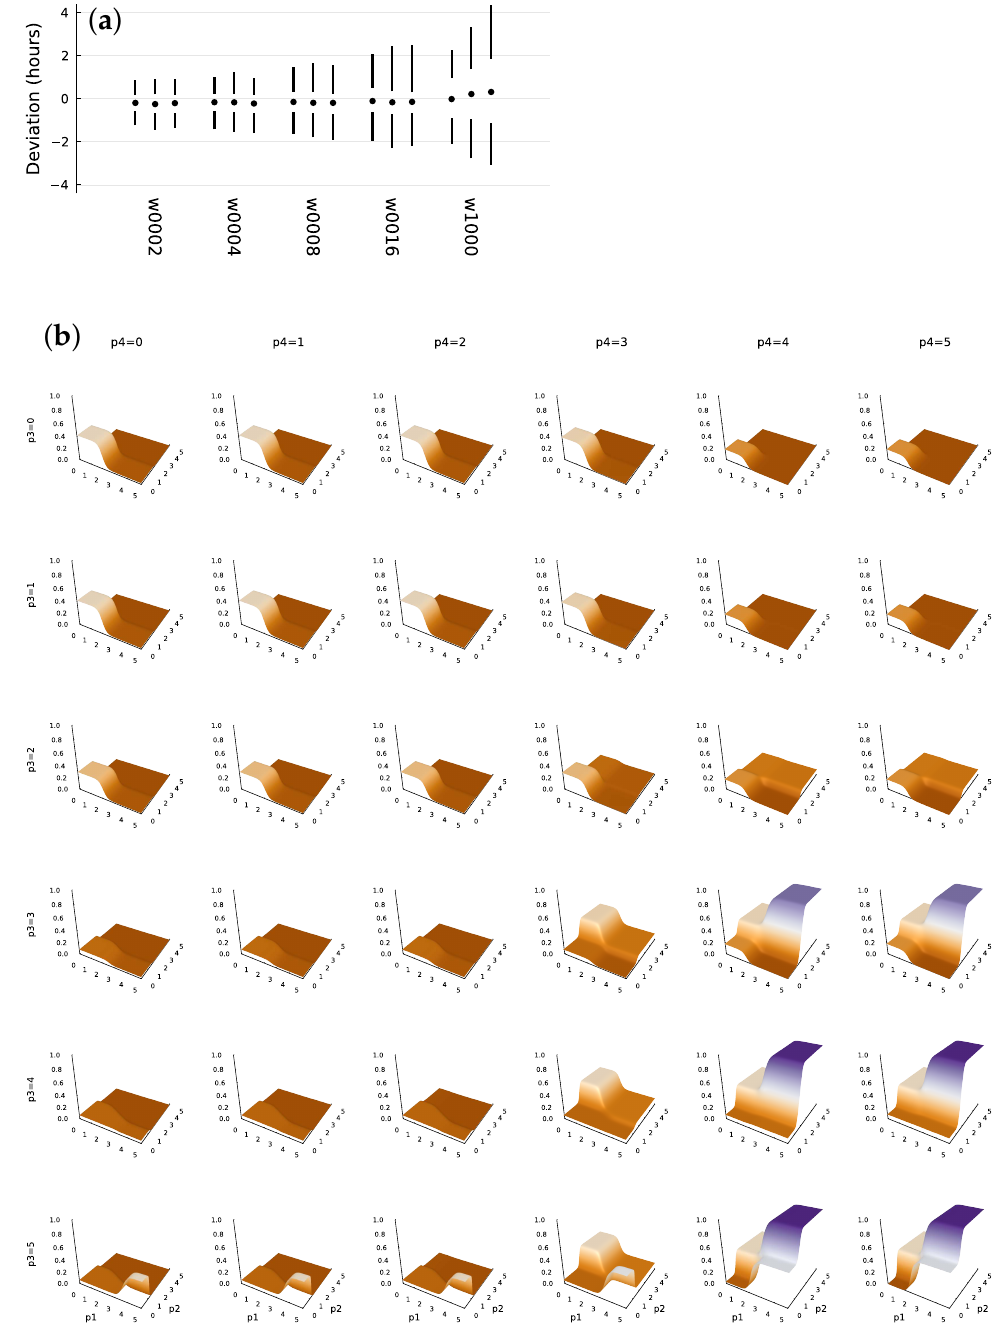
Figure 2. Stochastic perturbations to entrainment ( a ) and TF logic for mRNA expression ( b ). Panel ( a ) presents the deviation of cellular dynamics from the circadian target pattern. Each set of two vertical lines and a circle show the distribution of the deviation between the entry into daytime cellular state and the actual onset of daytime. The circle denotes the median of 1000 stochastic cellular trajectories. The upper line shows the 75th percentile at the bottom and the 95th percentile at the top. The